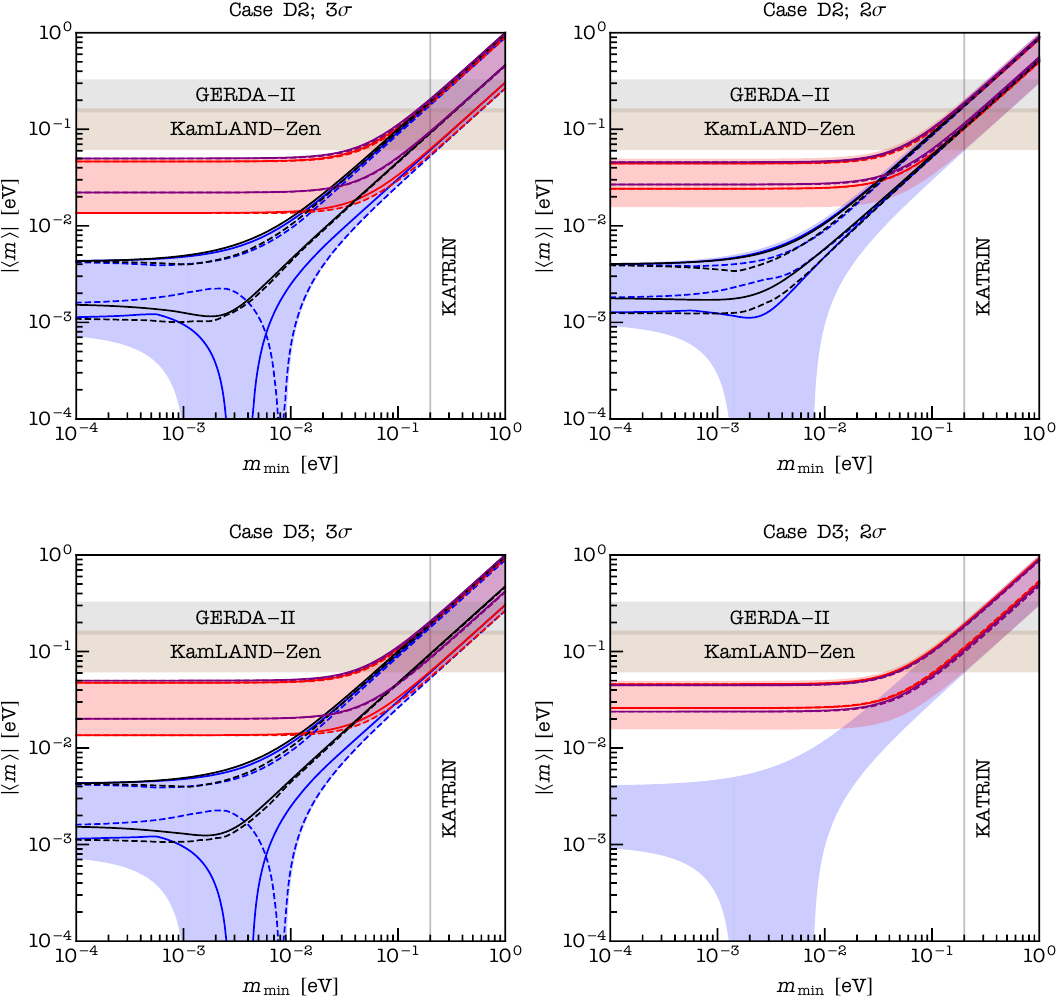
Figure 16 . The same as in (cid:12)gure 13, but for cases D2 and